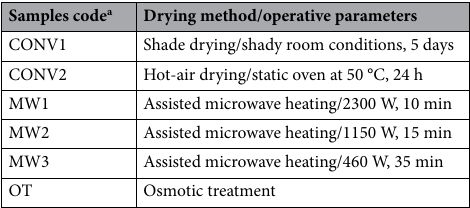
Table 2. Samples code and note on selected operative conditions of applied drying methods. a Untreated aerial parts are indicated as fresh